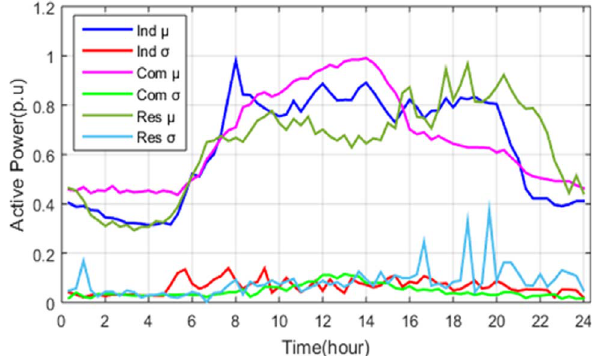
Figure 7. Analysis of day-to-day outlines of manufacturing load at the transmitter 1 thru summertime.